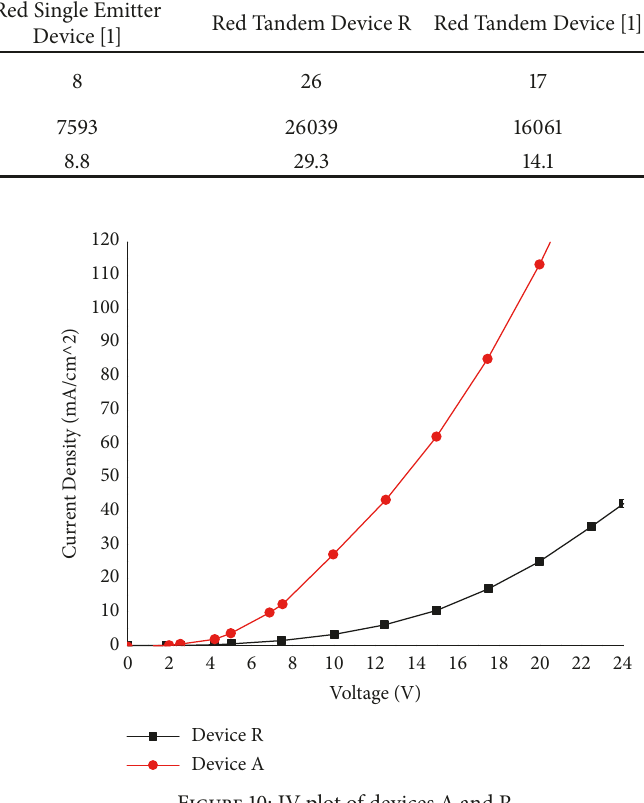
Figure 10: JV plot of devices A and